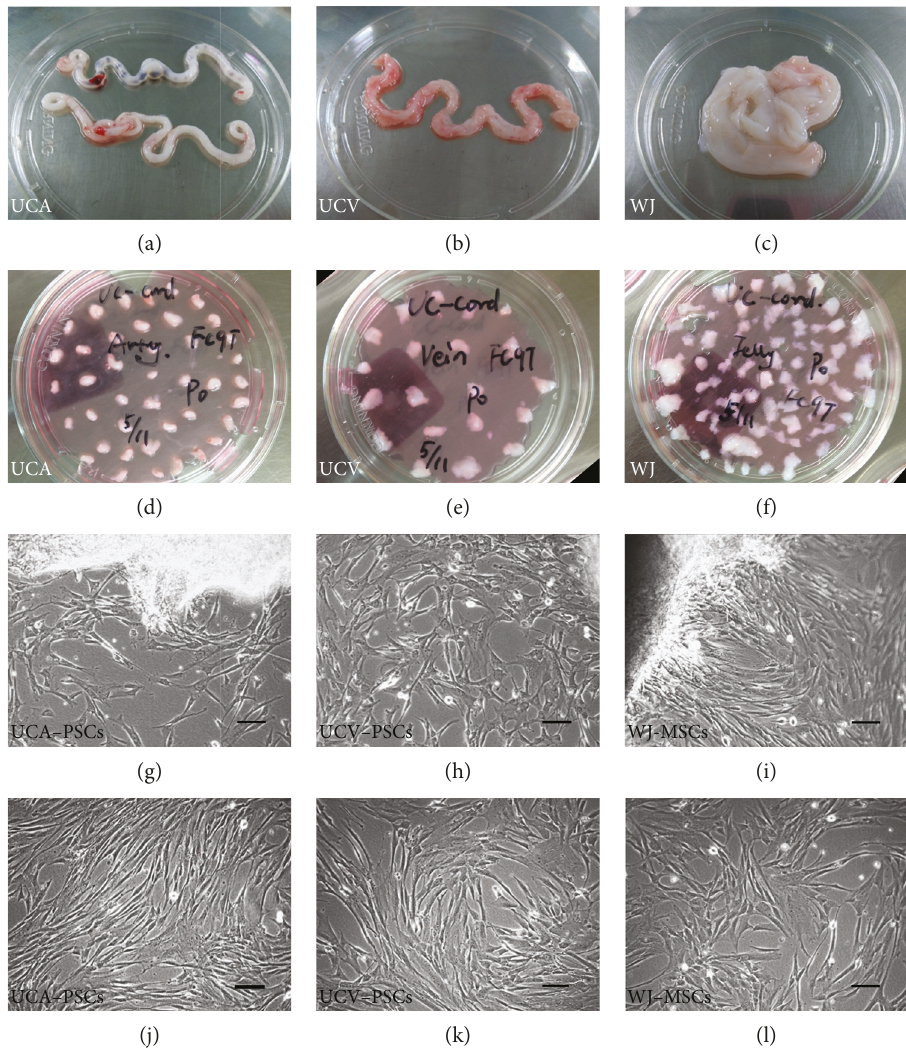
Figure 2: Isolation and characterization of umbilical cord artery perivascular stem cells (UCA-PSCs), umbilical cord vein perivascular stem cells (UCV-PSCs), and Wharton ’ s jelly mesenchymal stem cells (WJ-MSCs). (a – c) Three di ff erent compartments in human umbilical cord: umbilical arteries (UCA) (a), umbilical vein (UCV) (b), and Wharton ’ s jelly (WJ) (c). (d – f) Isolation of UCA-PSCs (d), UCV-PSCs (e), and WJ-MSCs in the human umbilical cord (f). (g – i) Cells from the third passage showed similar fi broblastic morphology. Bar: 100 μ